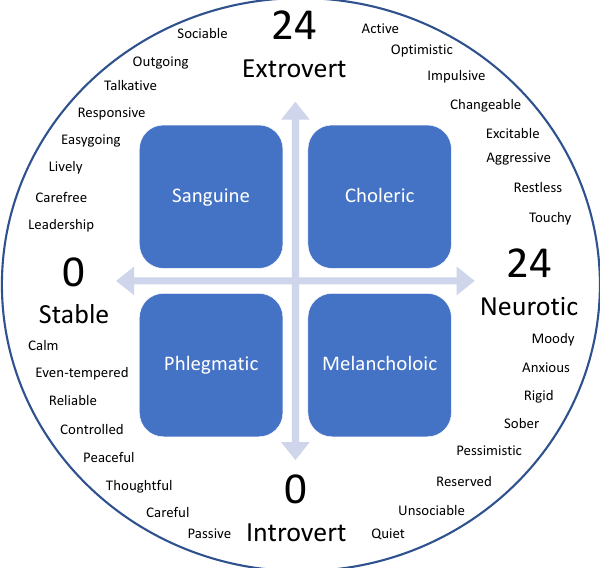
Figure 1. The Eysenck Personality Inventory (EPI). Note: The four quadrants in the figure above correspond to the four personality types outlined by the Eysenck Personality Inventory (EPI). The personality traits circling the figure are traits that are associated with each type.